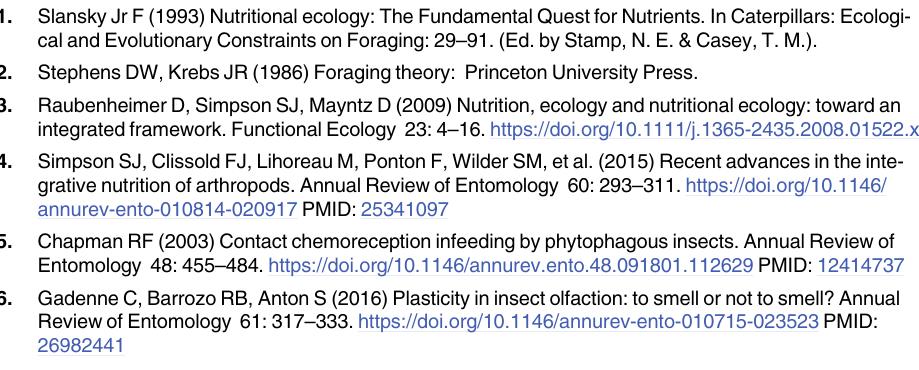
S1 Table. Foraging data and statistic